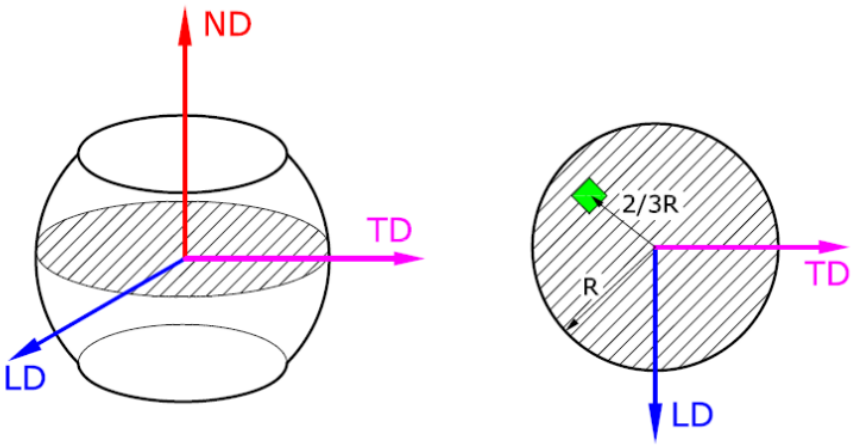
Figure 1. The reference system for the investigated samples: the initial deformed sample ( left ); the LD-TD section at middle-height of sample ( right ); the area investigated by SEM-EBSD analysis (green square); longitudinal direction (LD); transverse direction (TD); normal direction (ND).